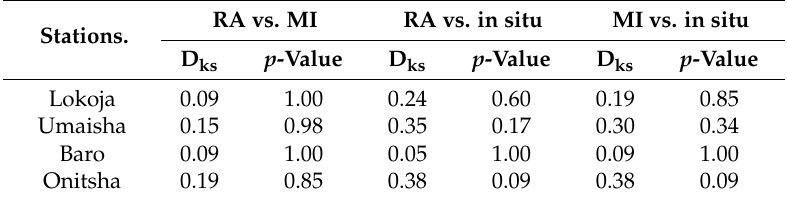
Table 10. Kolmogorov–Simonov (K–S) test results. RA vs. Stations.